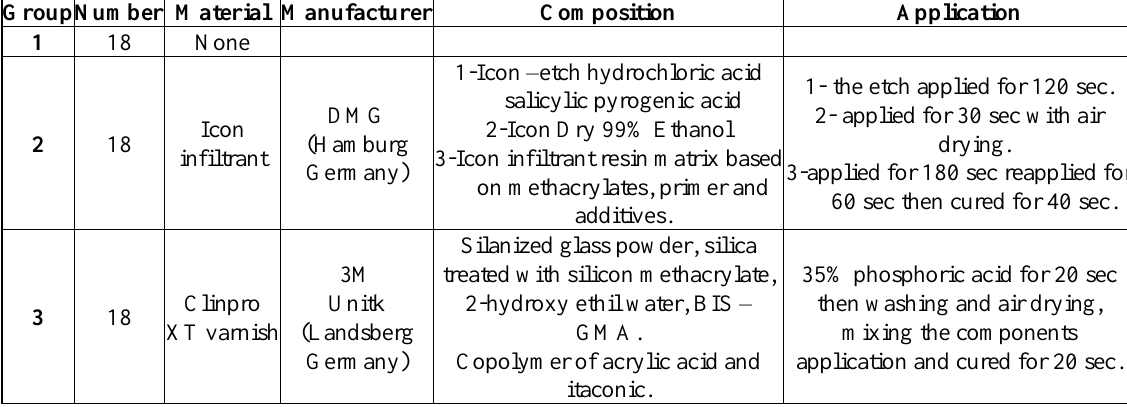
Table 1: Groups, material and application protocol used in the current